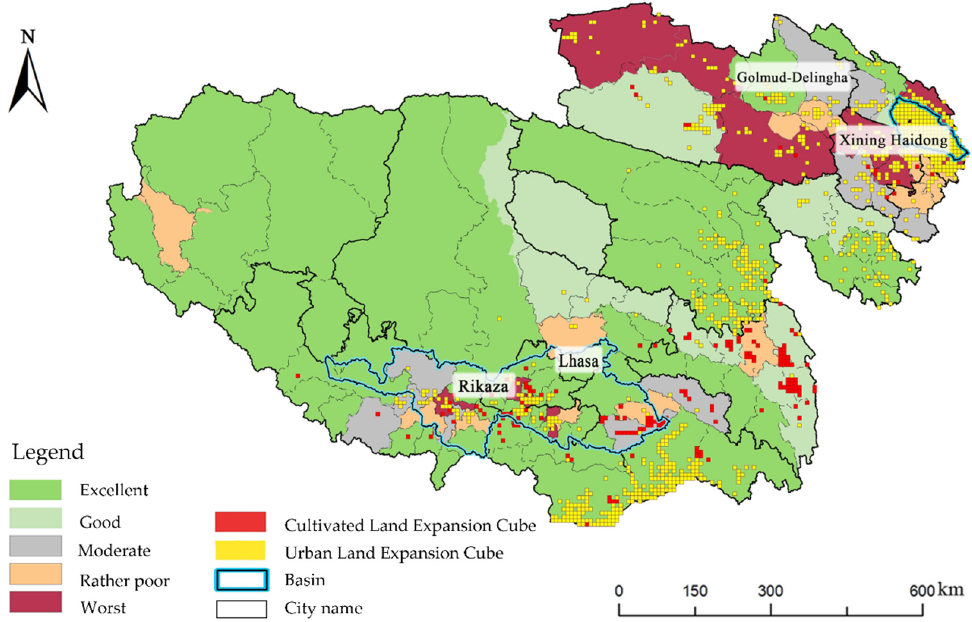
Figure 6. Long-time-series environmental quality evaluation results.